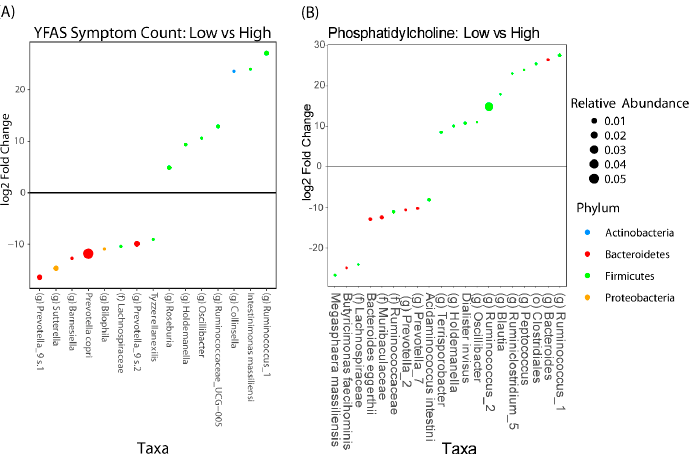
Figure 5. DESEq2 analysis adjusted for timepoints, showing the taxa that are associated with ( A ) YFAS symptom count and ( B ) phosphatidylcholine metabolite and 1-palmitoyl-2-palmitoleoyl. Taxa that have a positive fold change are those that are associated with a lower YFAS symptom count or 1-palmitoyl-2-palmitoleoyl level, respectively.